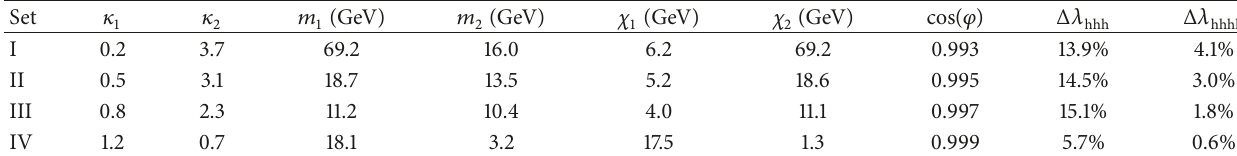
Table 1: Different configurations associated with the onset of a strong first-order phase transition ( 𝜉 = 1 ).